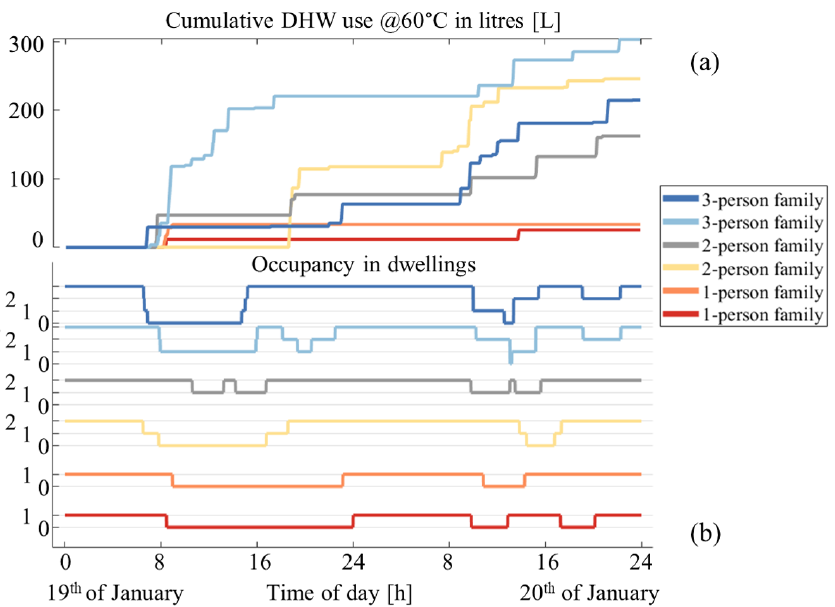
Figure 3. Example of a DHW profile ( a ) and occupancy profile ( b ) for six different families. The pro- files are given for the 19th and 20th of